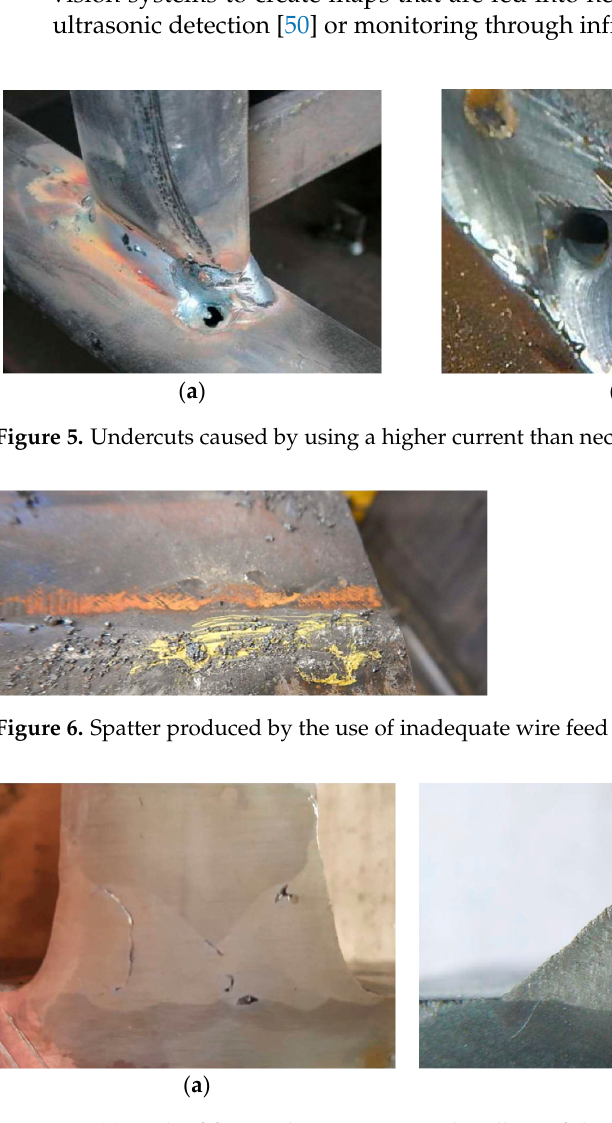
Figure 4. Porosity: ( a ) surface porosity uniformly distributed along the weld seam is produced because the displacement angle is too large (excessive slope); ( b ) porosity occurred because the gun is too far away from the workpiece or the voltage has been insufficient at the welding distance.